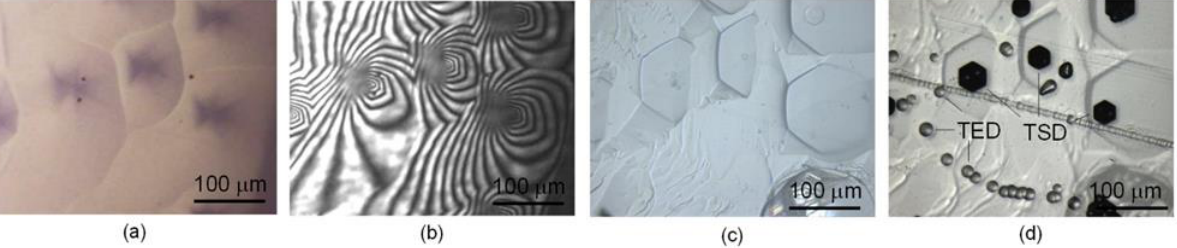
Figure 4. Correlation between dissolution pits on C face of 4H-SiC and dislocations: ( a ) in situ observation image of SiC/alloy interface by bright-field optics, ( b ) corresponding in situ observation image taken by interference optics, ( c ) ex situ image after cooling, and ( d ) ex situ image after KOH etching. Note that the photos for ( c , d ) were also taken from the Si face side because the KOH etch pits were formed on the Si face.